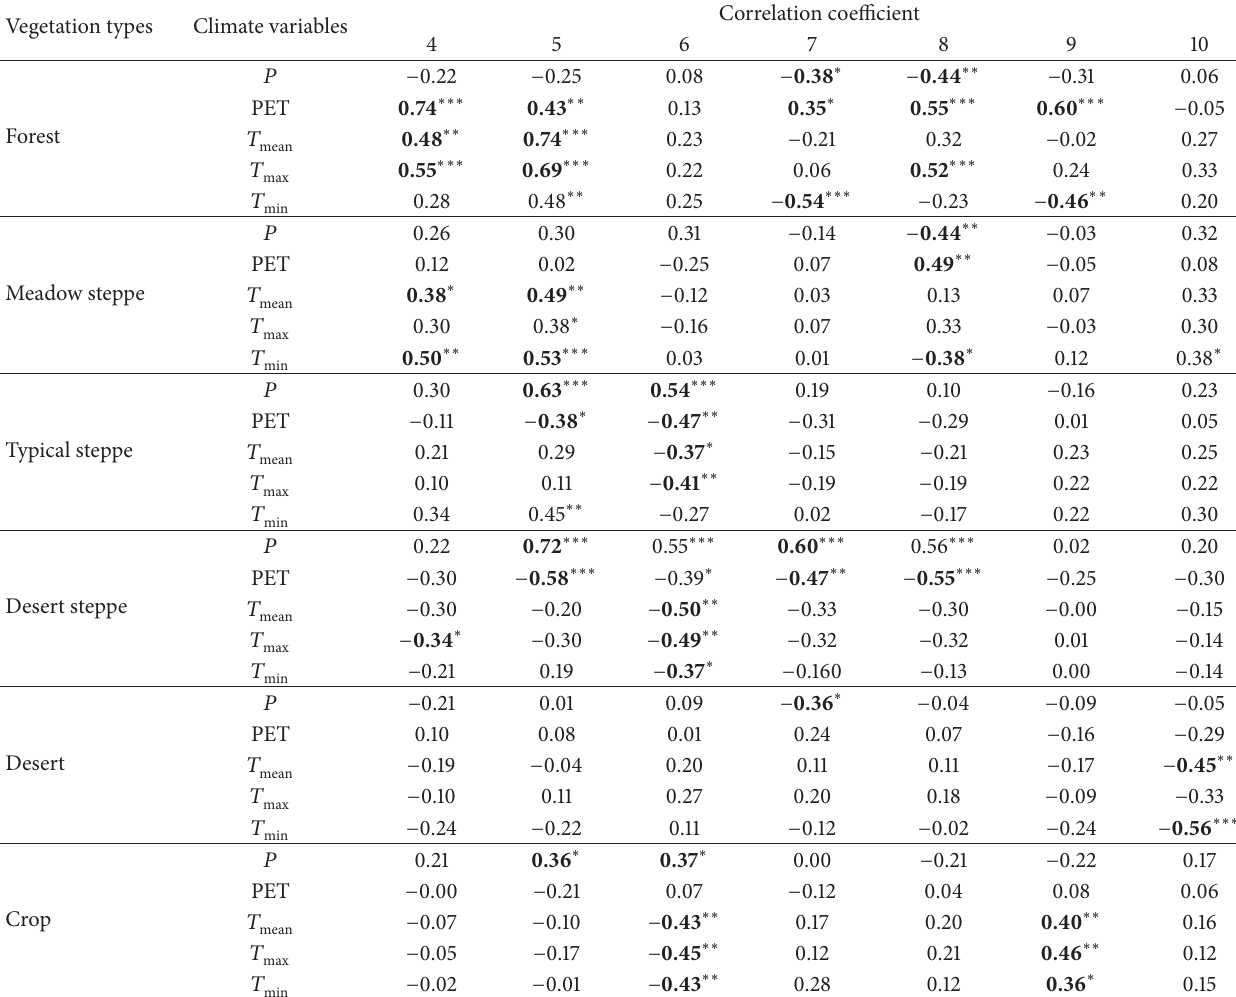
in the same month for different vegetation